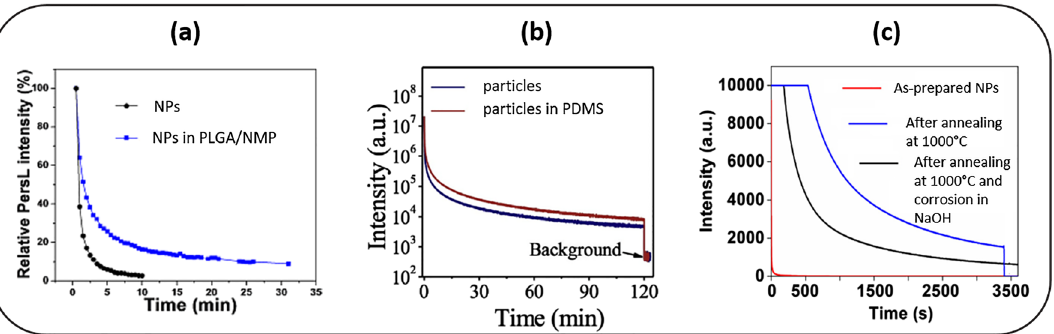
Figure 9: Persistentluminescence decaycurves of (a) ZGO:Crnanoparticles in water as comparedto ZGO:Cr nanoparticles inPLGA/NMPafter 2 min white LED charging [147] (b) NYF:Yb,Tm/SAO:Eu,Dy particles (mass ratio 1:10) with and without the protection of PDMS after 5 s 980 nm laser charging [144] (c) ZGGO:Cr,Yb,Er particles prepared by hydrothermal synthesis after 5 min 254 nm UV lamp charging [148]. Reproduced with permissions from [144, 147, 148].